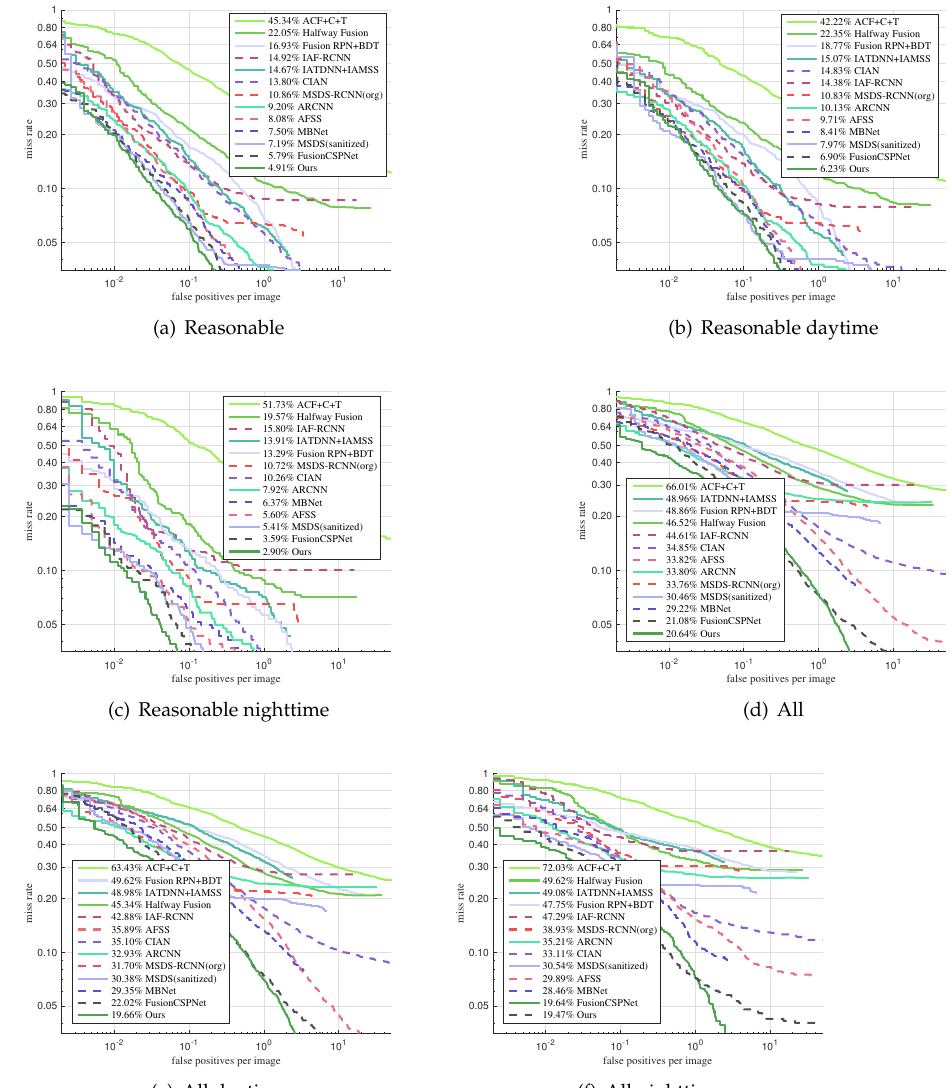
Figure 6. Comparison of the detection results on the KAIST dataset in reasonable and all settings: all day, daytime, or nighttime. ( a ) Reasonable all-day, ( b ) reasonable daytime, ( c ) reasonable nighttime, ( d ) all all-day, ( e ) all daytime, and ( f ) all